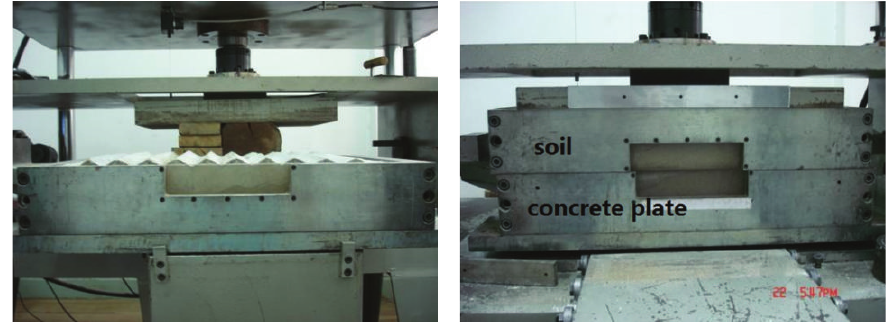
Figure 2: Setup of the specimen